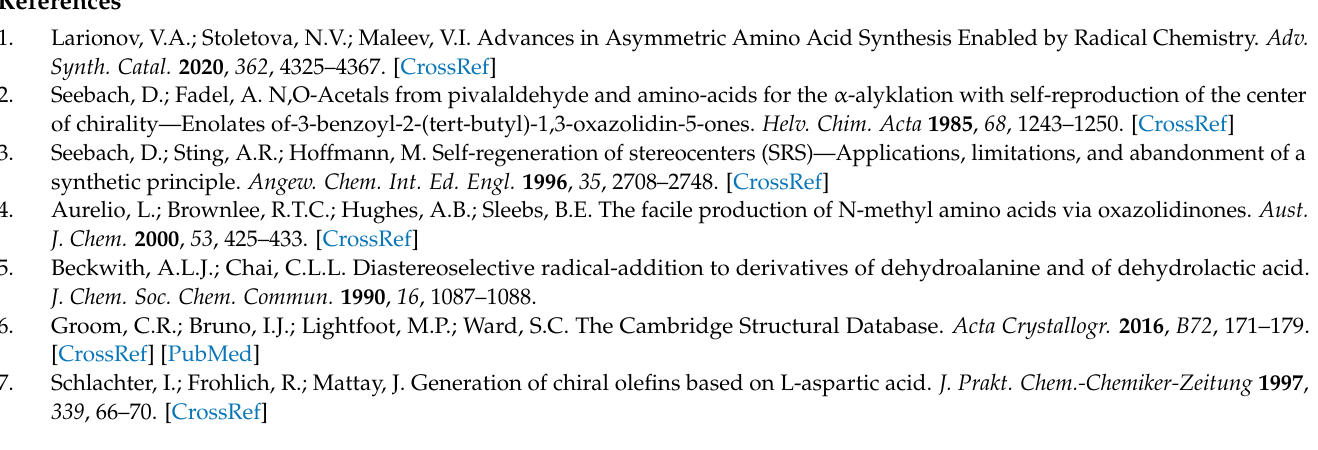
Figure 6. Fragment of the crystal structure of ( II ) showing part of a [100] chain linked by C1–H1 ··· O3 hydrogen bonds. Symmetry code: (i) x − ½, ½ − y , 1 − z .